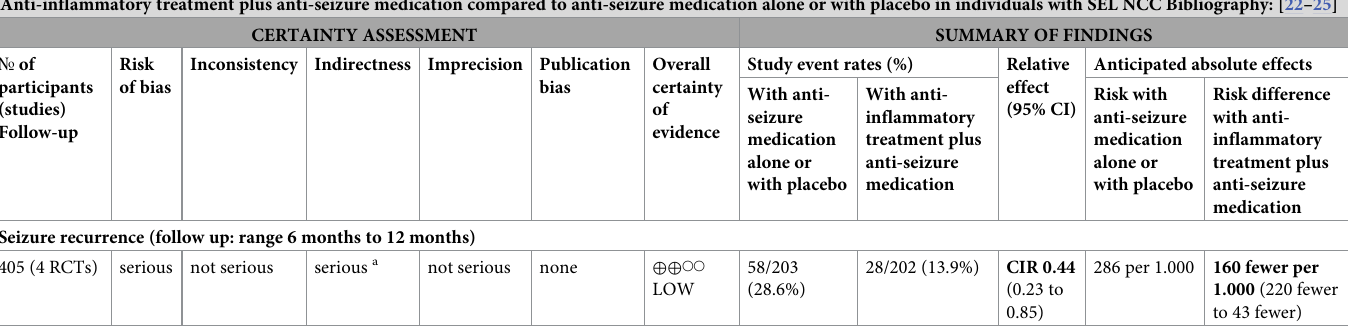
Table 3. GRADE table anti-inflammatory